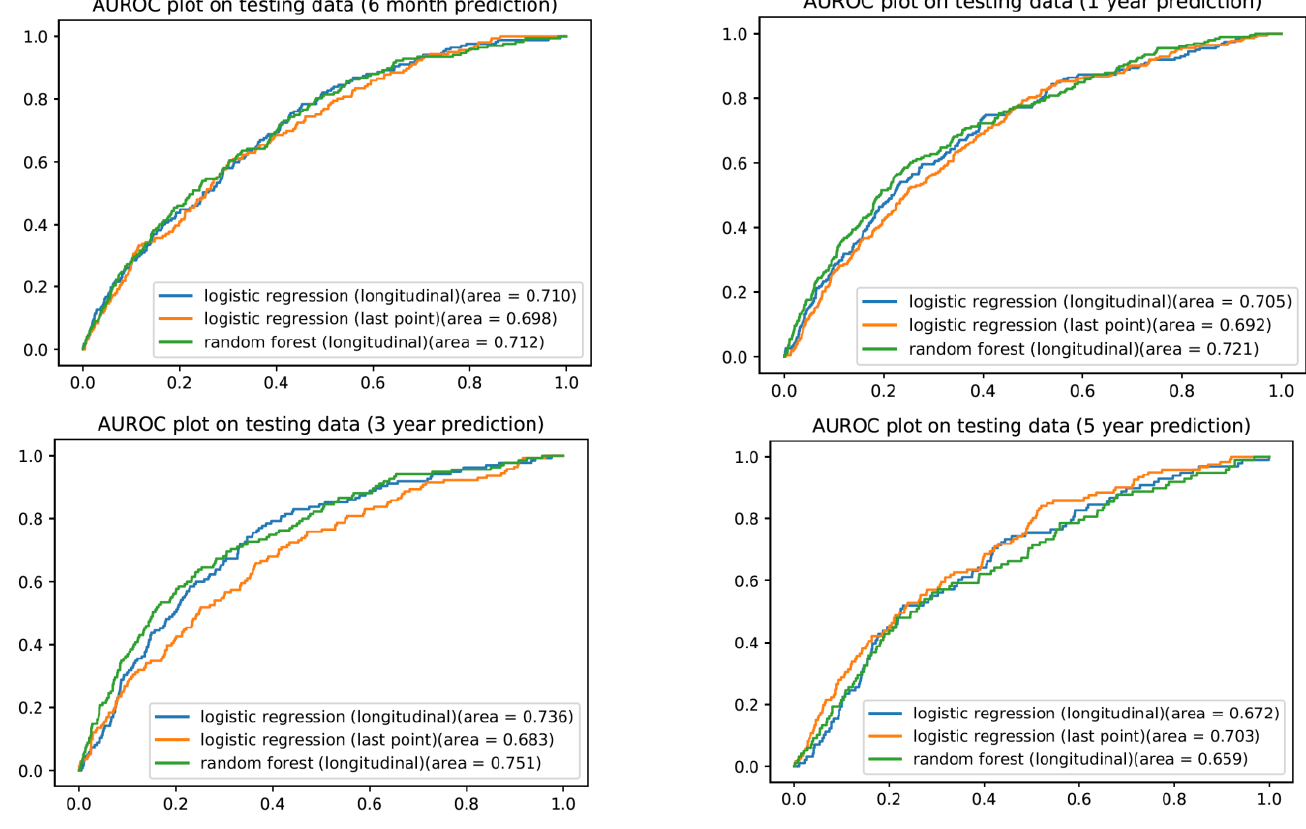
Figure 1. Receiver operator curves for GI tract cancer prediction at 6-months, 1-year, 3-years, and 5-years.